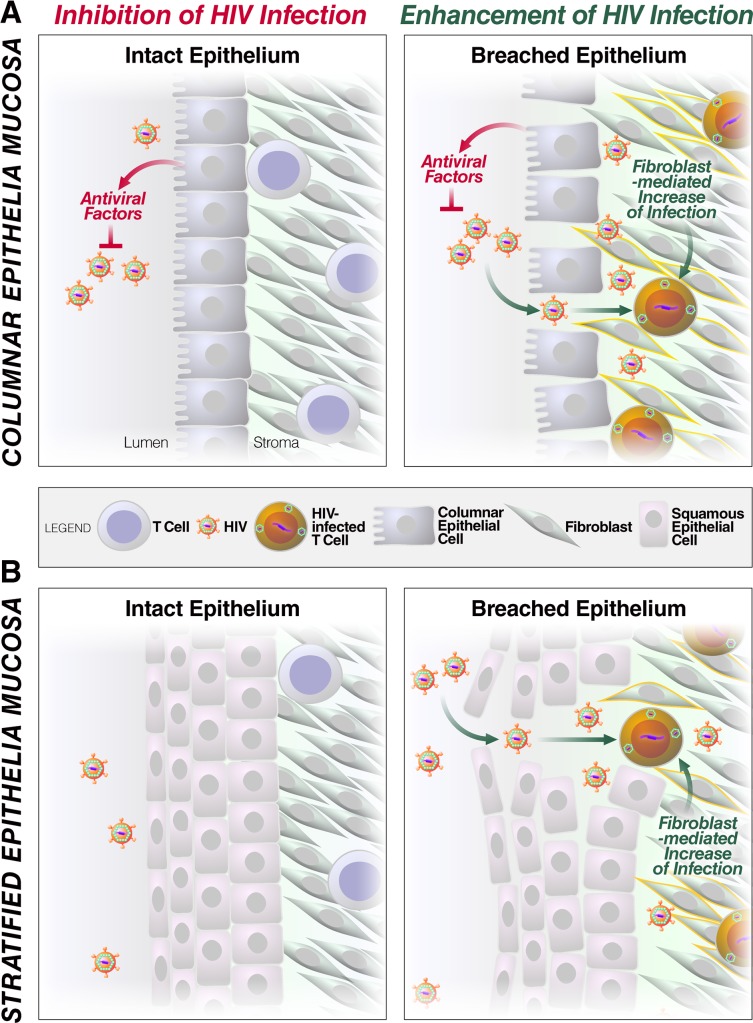
Model of fibroblast-mediated enhancement of HIV infection at mucosal portals of entry.(A) In mucosal tissues lined by single-layered columnar epithelia, such as the endometrium, when barrier function is intact, antiviral factors secreted by the epithelium limit HIV infection. Breaches in the epithelium caused by physical trauma, ulcerative sexually transmitted diseases, or the effects of progesterone facilitate migration of HIV into the stromal compartment. This compartment can be exposed to antiviral factors, either through entry from the lumen or through basolateral secretion of these factors by the epithelial cells, but is also replete with fibroblasts which can enhance HIV infection of resident CD4+ T cells. (B) Breaches in mucosal tissues lined by multi-layered squamous epithelia (e.g. ectocervix and foreskin) similarly lead to increased likelihood of transmission due to increased access to fibroblasts.